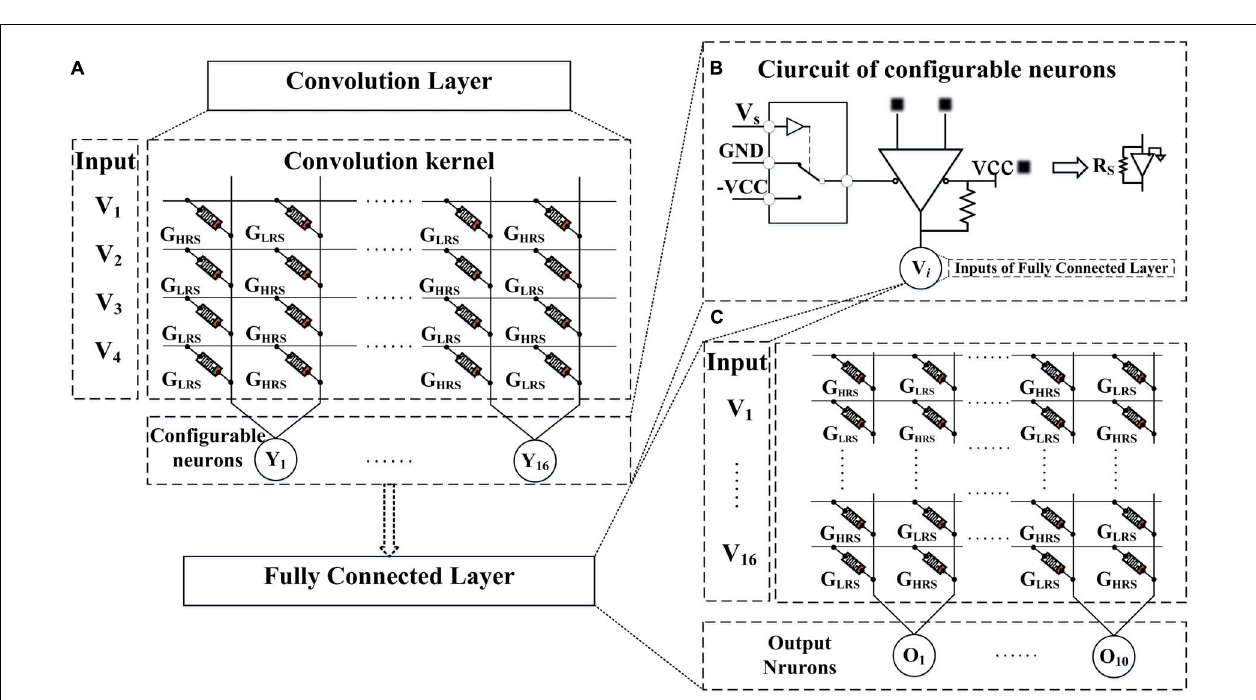
FIGURE 5 | Memristor array structure of the convolution kernel. The pixels in the sliding window are convolved with 9 × 9 kernel using the memristor array.